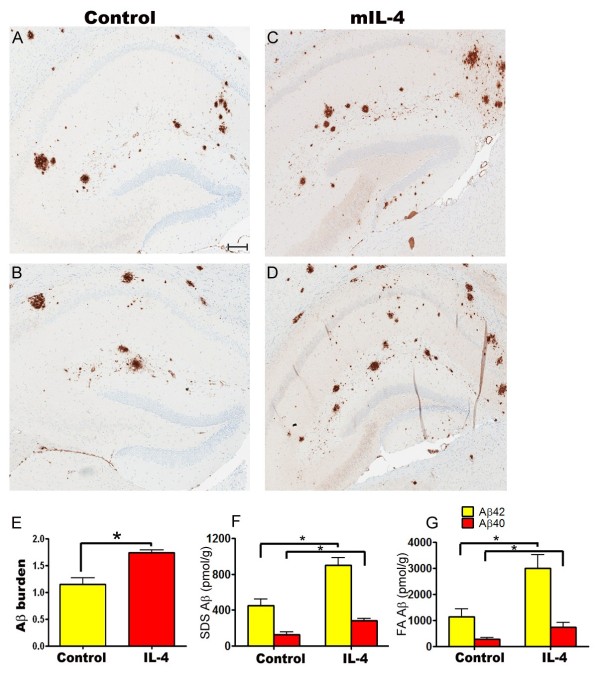
Increased Aβ deposition in AAV1-mIL-4 expressing TgCRND8 mice. A-D. 4 month old TgCRND8 mice were stereotaxically injected in the hippocampus with either AAV1-mIL-4 (C, D) or AAV1-EGFP (A, B) and sacrificed after 6 weeks (n = 5-6/group). Representative brain sections stained with 33.1.1 antibody (pan Aβ 1–16) depict increased Aβ deposition in mIL-4 expressing mice (C, D) compared to controls (A-B) in the immediate vicinity of the injection site. Scale Bar, 150 μm. E. Aβ plaque burden analysis shows a significantly increased amyloid deposition in mIL-4 injected mice compared to control EGFP injected mice (n = 5/group). (*p < 0.05, t test). Data represents mean ± sem. F-G. Biochemical analyses of Aβ42 and Aβ40 levels by ELISA show significantly increased SDS (F) and formic acid (G) extractable Aβ levels in mIL-4 injected mice compared to controls (n = 5/group). (*p < 0.05, t test). Data represents mean ± sem.